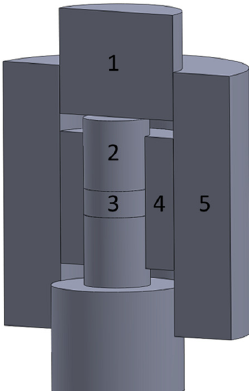
Figure 2. Schematics of the double-die SPS setup used in this study: 1—Large punch; 2—Small punch; 3—Specimen; 4—Small die; 5—Large die.